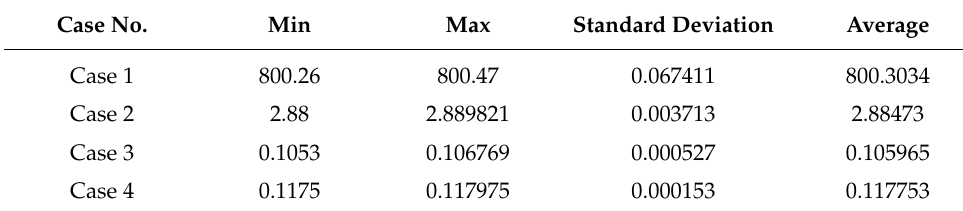
Table 9. Statistical indices for the studied cases.